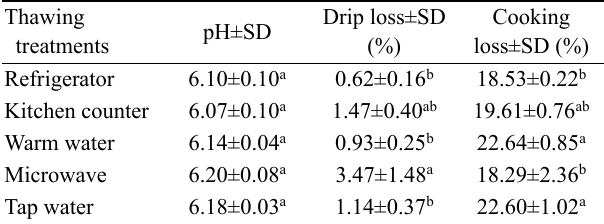
Table 6. pH, drip loss and cooking loss values of chicken breast the samples after defrosting using home based thawing practices